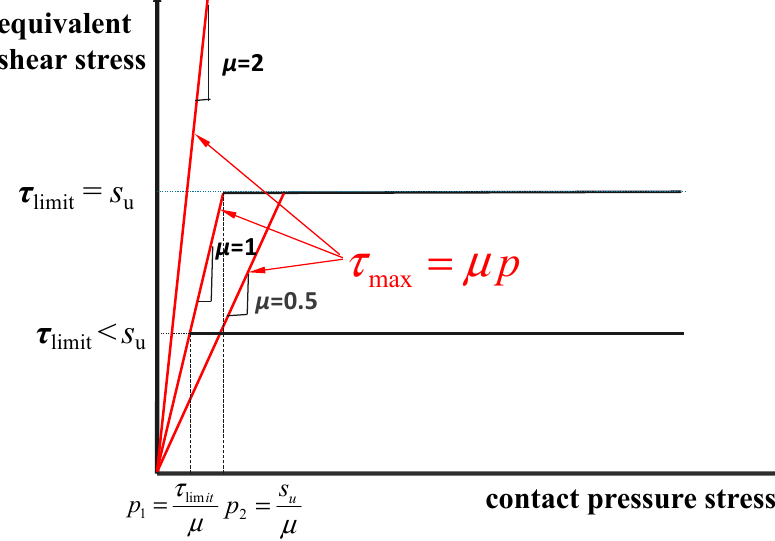
Figure 9. Behavior of the contact element in Abaqus/CEL.